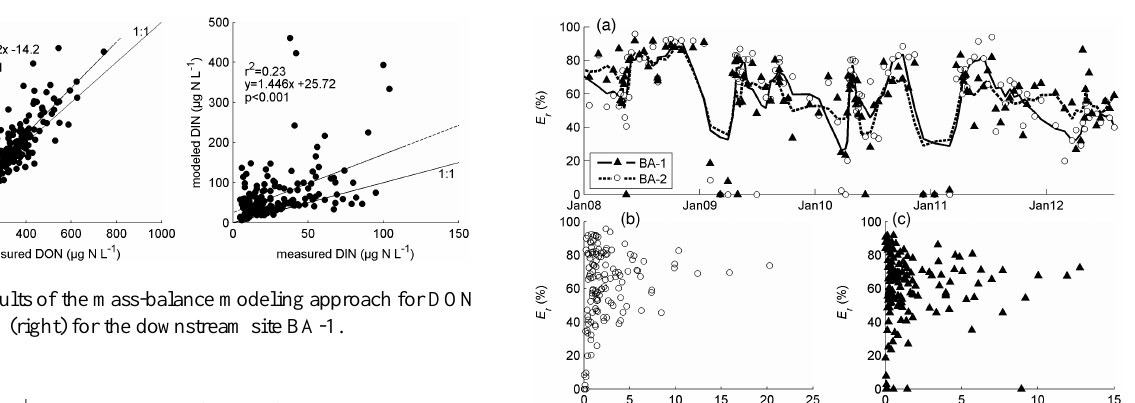
removal efficiency ( E r ), 3